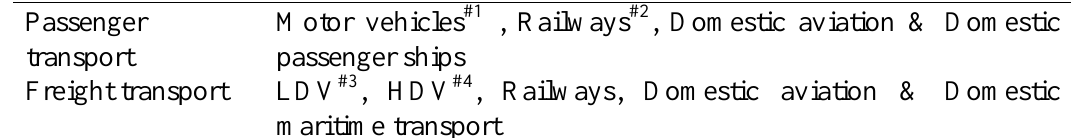
Table 3. Categories of transport modes in the case study (Japan as a whole) Passenger